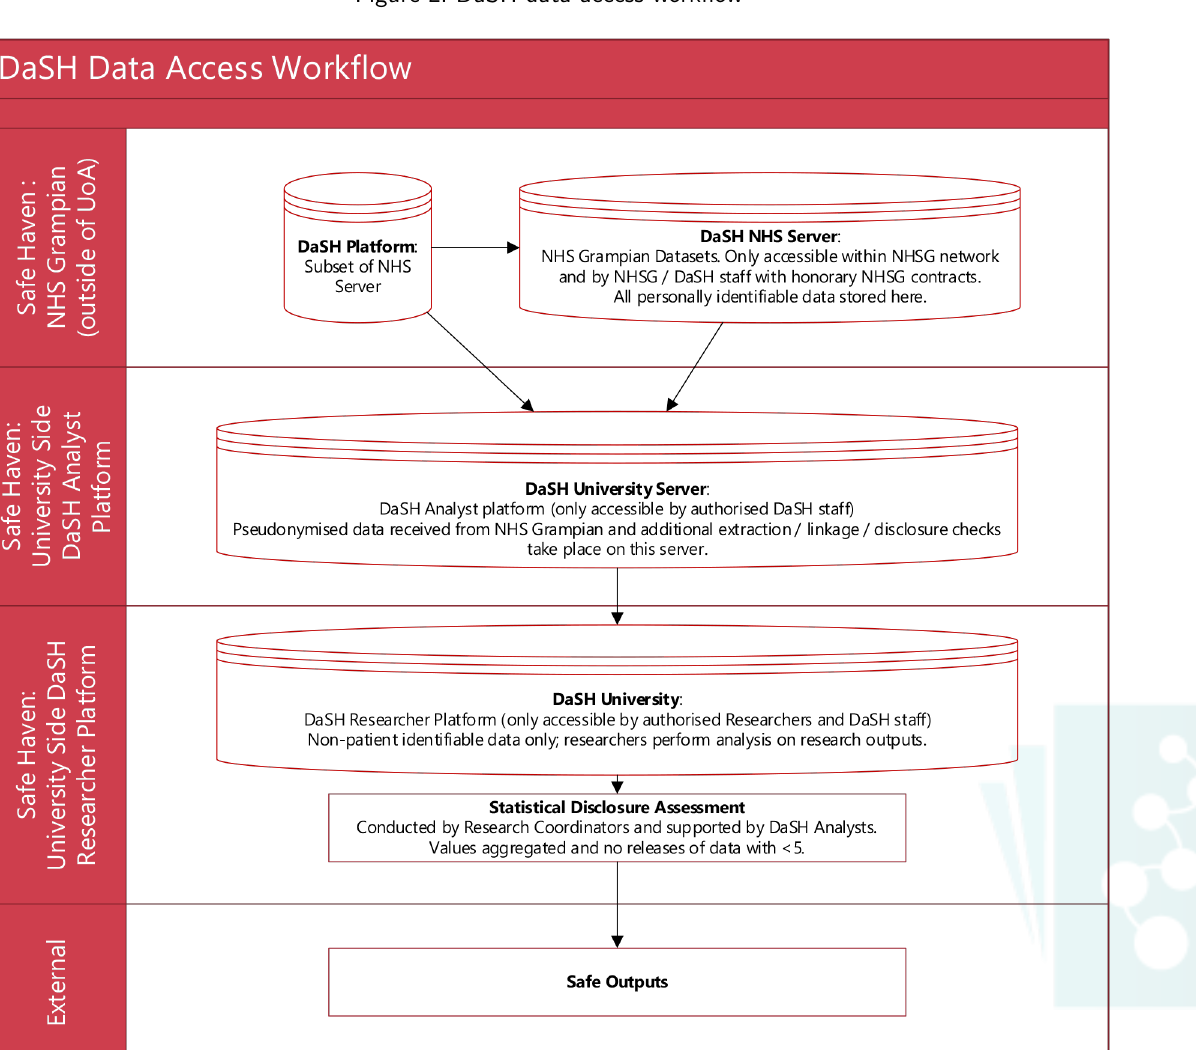
Figure 2: DaSH data access